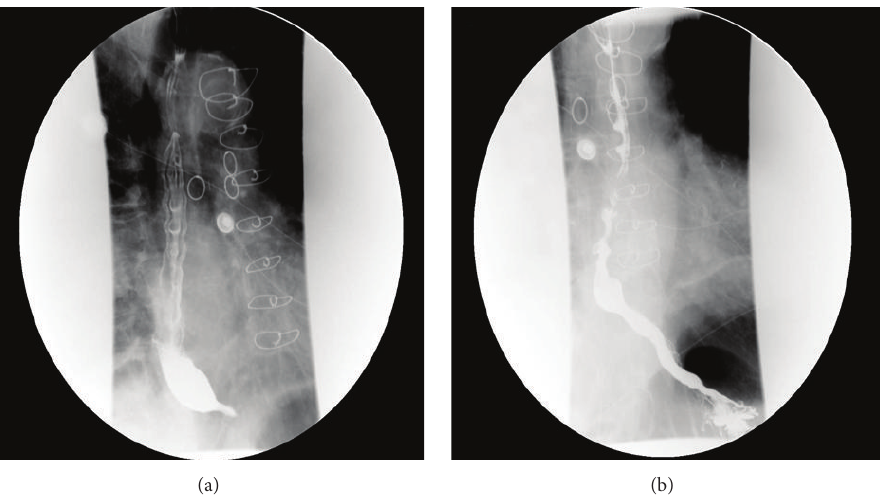
Figure 2: (a) Smooth short stricture in the distal esophagus slightly proximal to the gastroesophageal junction. This may represent a stricture or spasm related to reflux. (b) Multiple tertiary contractions of the distal esophagus suggestive of dysmotility.